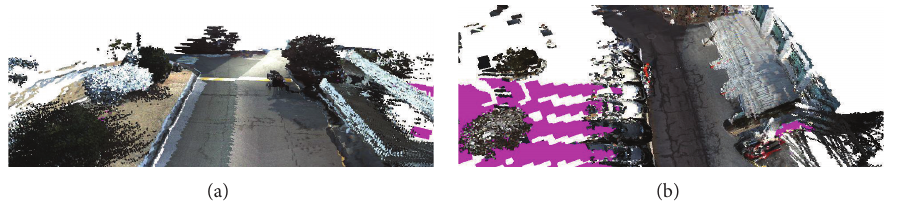
Figure 12: Terrain reconstruction results using ground segmentation method. (a) Nonground voxel map and ground texture mesh representation. (b) Reconstruction result of another environment.